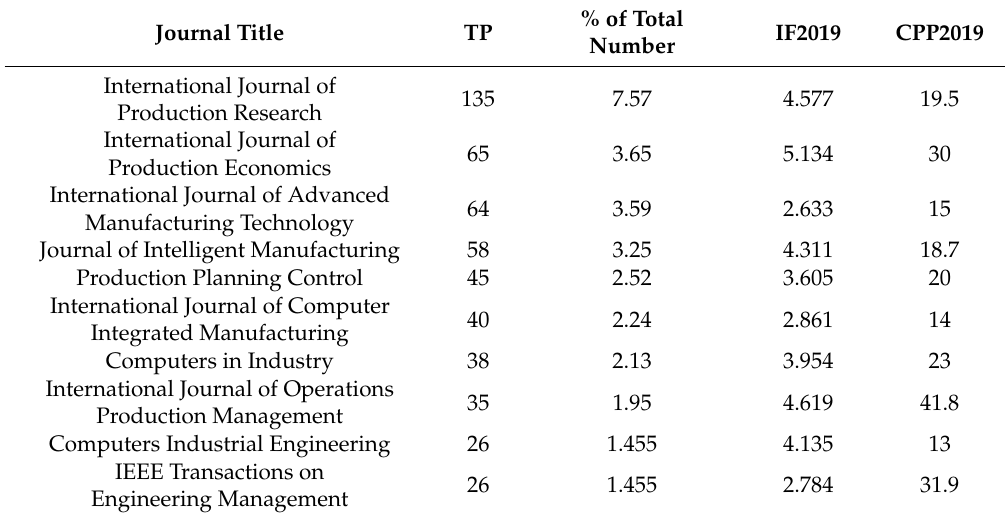
Table 2. Top 10 most cited scientific journals of the Mass Customization research domain in 1990–